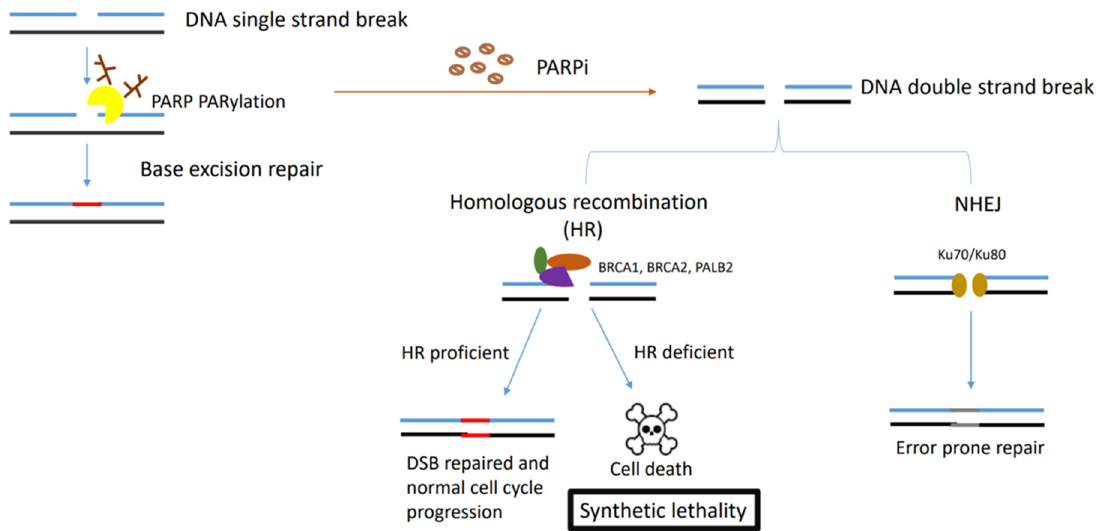
Figure 1. Figure describing the synthetic lethality interaction between PARPs and BRCA1/2 . PARP binds to the single-strand DNA break sites, and results in the PARylation of target proteins and recruitment of the DNA damage repair effectors. In HR-deficient tumour cells (BRCA1-, BRCA2- or PALB2-deficient cells) treated with PARPi, NHEJ is the only pathway initiated in double-strand DNA repair, which leads to accumulation of genome instability and cell death for the low fidelity.